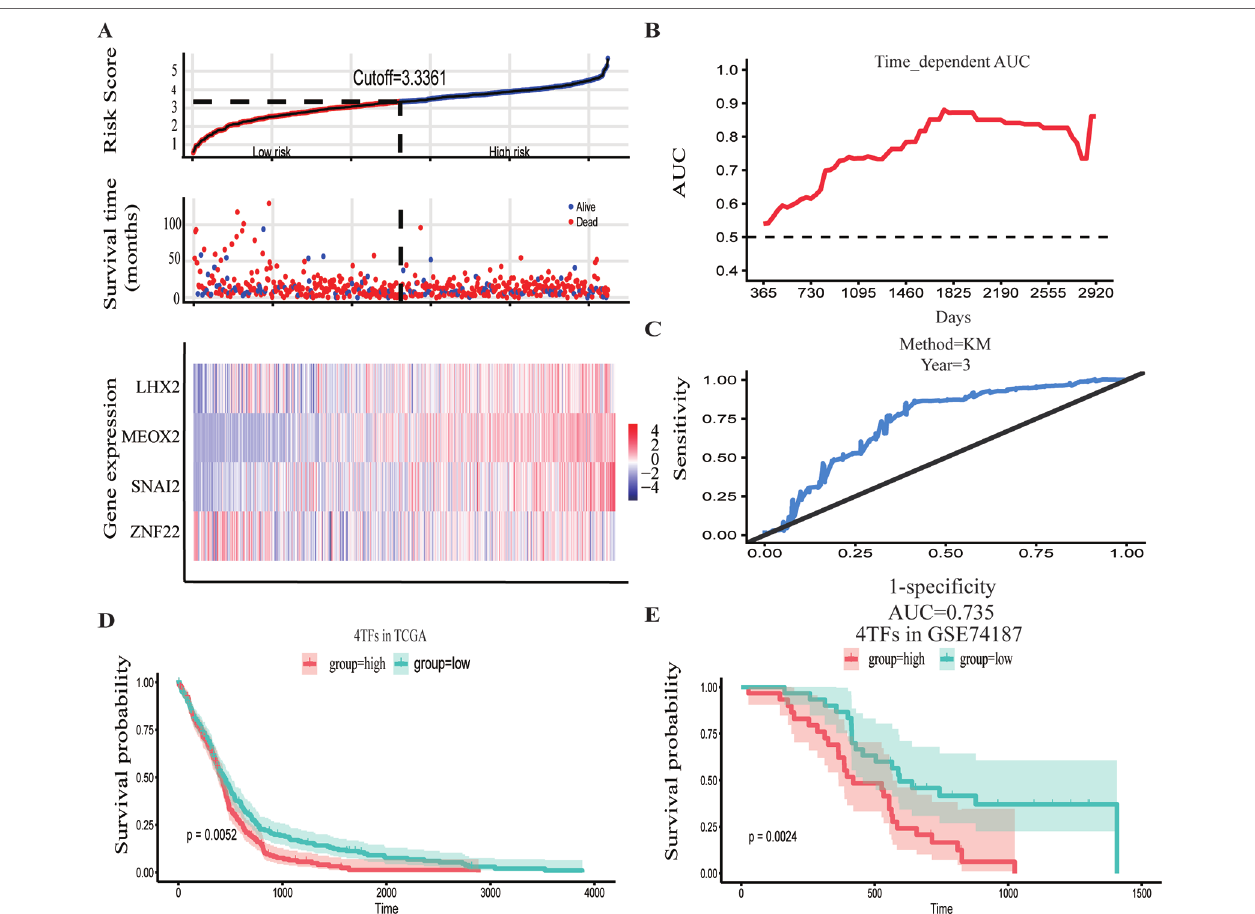
FiGURe 3 | Construction and verification of the hazard assessment system. (A) The distribution of risk score, patient survival time and status in The Cancer Genome Atlas (TCGA) set, and heatmap of the gene risk assessment model in TCGA dataset. (B, c) The area under the curve (AUC) for the risk assessment model in TCGA set and time-dependent receiver operating characteristic (ROC) for predicting the 3-year survival. (D, e) Kaplan–Meier curves of the high-risk group and low-risk group of TCGA dataset and GSE74187 dataset.